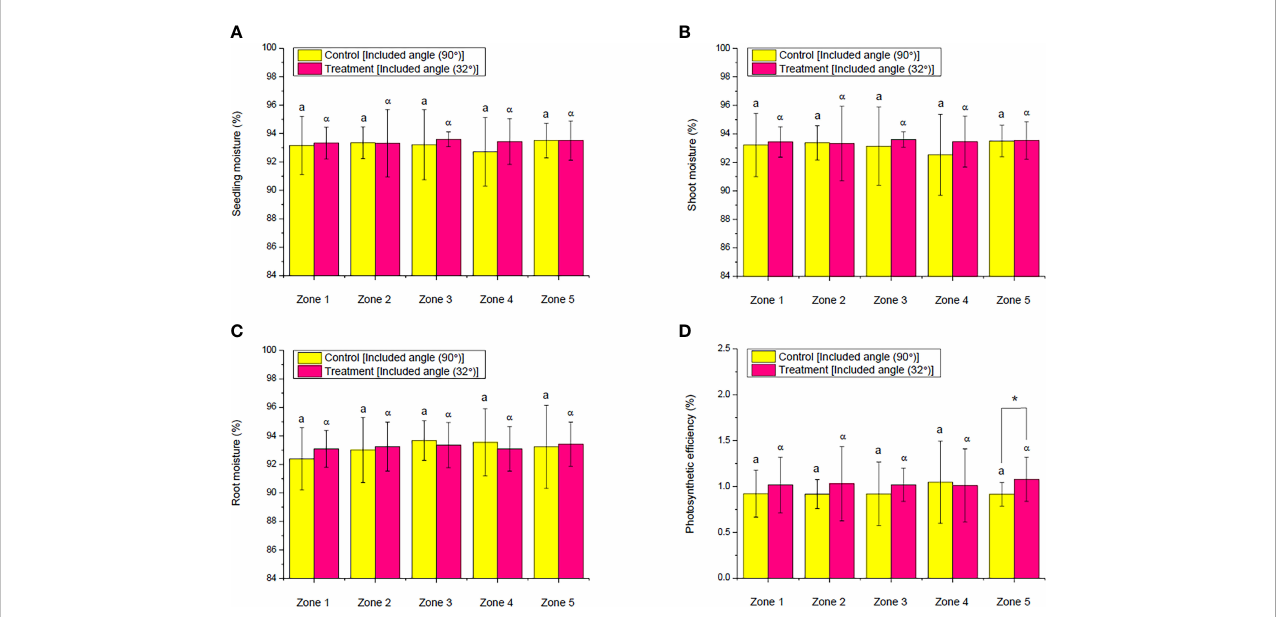
FIGURE 11 Comparison of the moisture of (A) seedling, (B) shoot, and (C) root as well as (D) photosynthetic ef fi ciency of choy sum at seedling stage on day 16 grown in an indoor farm rack with and without the application of an adjustable lampshade-type re fl ector (ALR). The asterisks (*) indicate signi fi cant differences found between the control and treatment (Student ’ s t -test; p < 0.05), while the lone Greek alphabet ( a ) and the lowercase letter (a) indicate that there are no signi fi cant differences found among all the zones with and without the application of ALR ( N zone1 = 45, N zone2 = 38, N zone3 = 32, N zone4 = 26, N zone5 = 19, one-way ANOVA; Tukey multiple-comparison; p < 0.05).